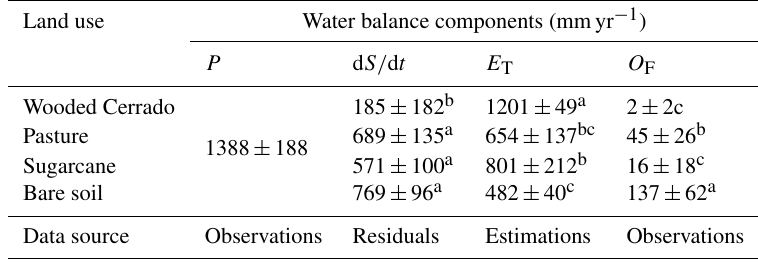
Table 3. Mean and standard deviation of the annual water balance components for 2012–2016 period.